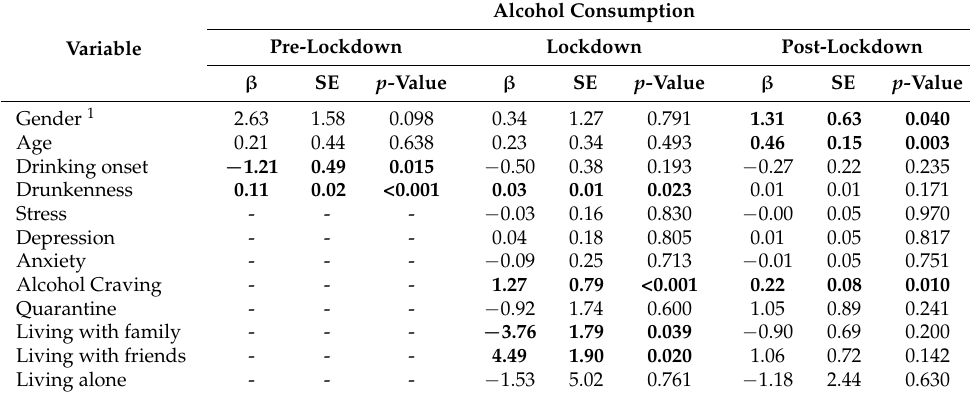
Table 2. Results of the linear regression